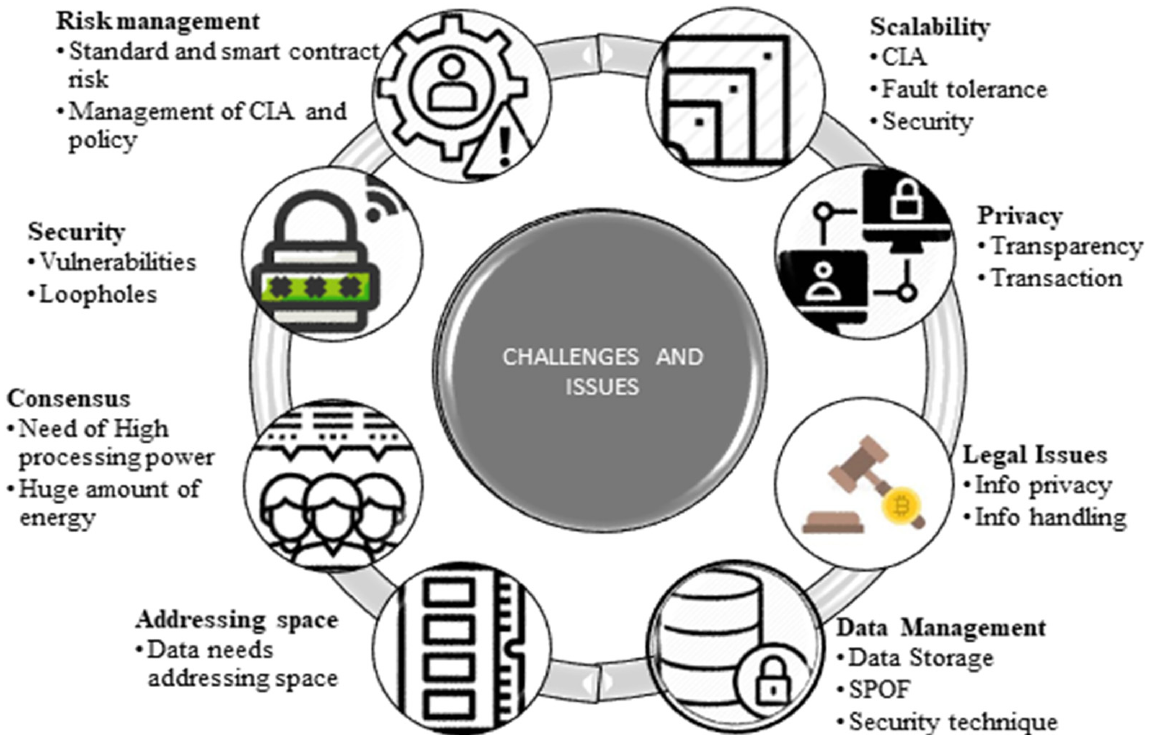
Figure 4. Challenges of Industry 4.0.